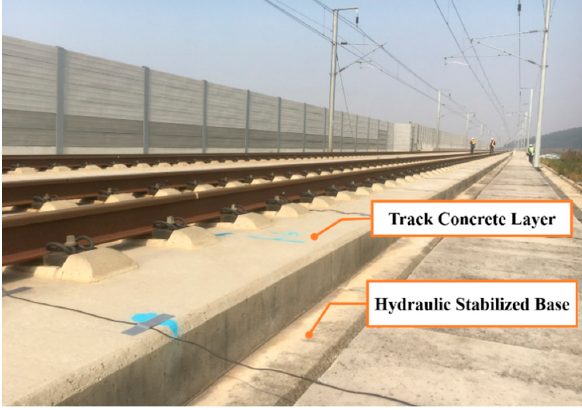
Figure 18. Track system of high-speed railway in Korea.